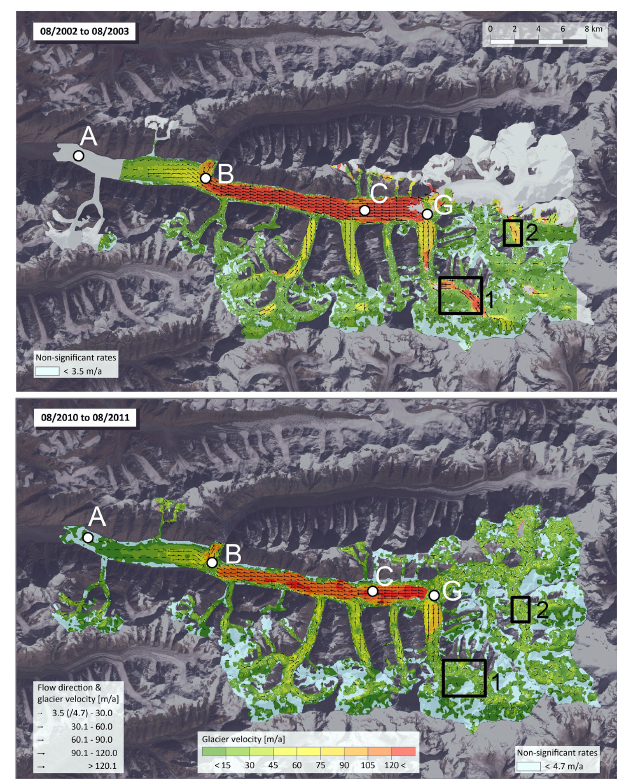
Figure 3. Mean annual flow direction and velocity of SIG in the time intervals 2002–2003 (a) and 2010–2011 (b) .